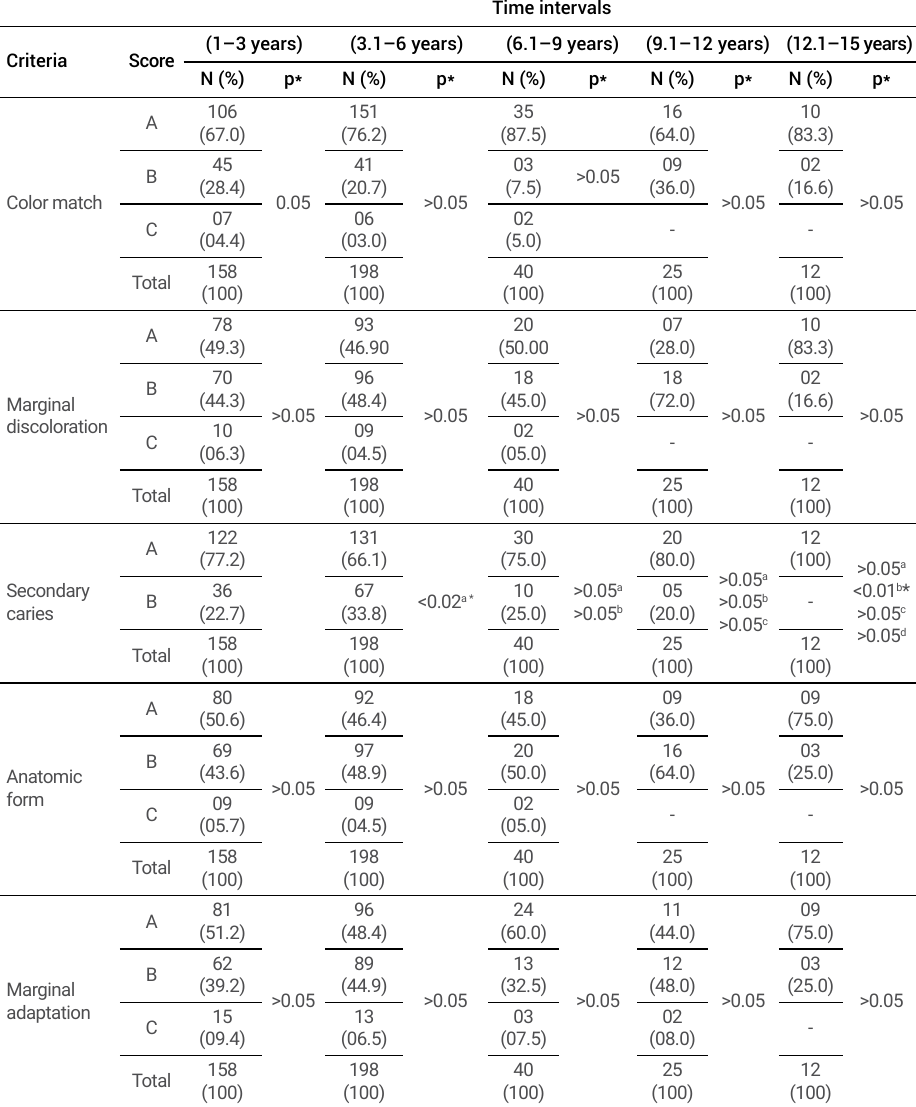
Table 3. Frequency of failure of RC restorations according to the Ryge criteria in relation to the time of placement.